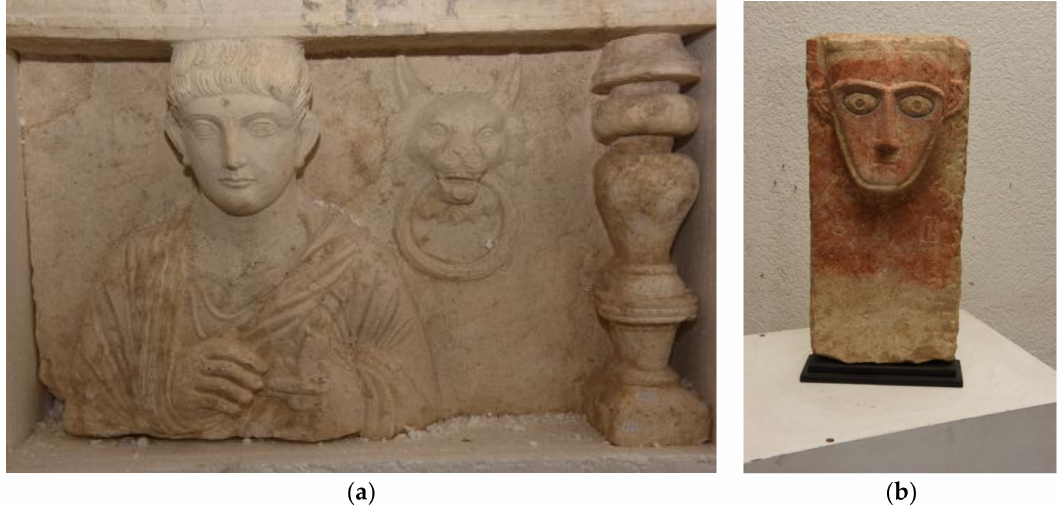
Figure 4. Two of the artifacts seized from Swiss free port (Geneva Public Ministry 2016). ( a ) Relief from the UNESCO World Heritage Site of Palmyra, Syria. ( b ) Yemeni carved ancient